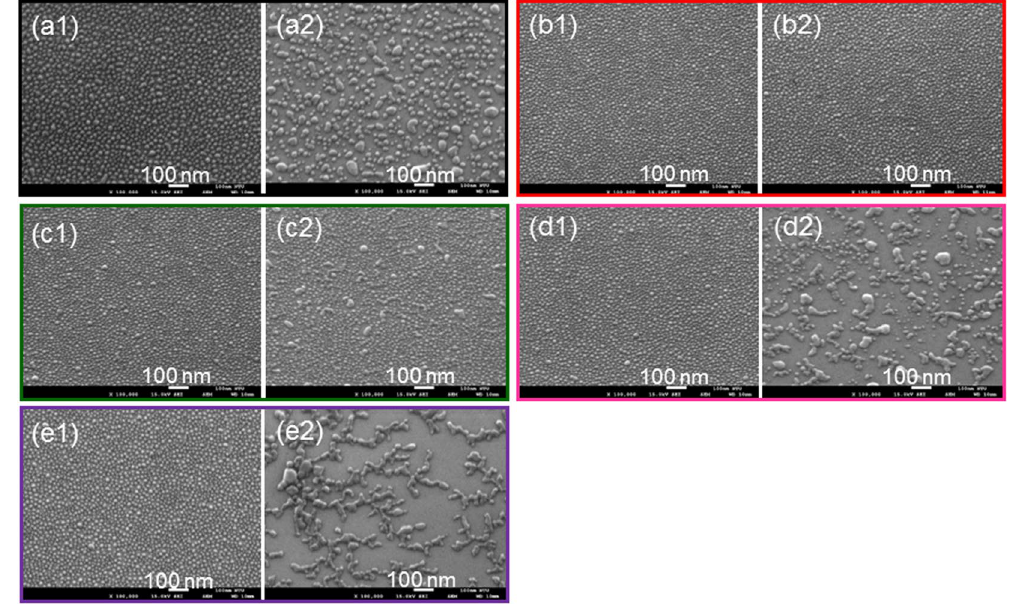
Figure 1. ( a1,a2 ) SEM images of fresh surface Ag NPs and the Ag NP structure 16 hours later under the indoor natural condition, respectively, on a GaN template. ( b1,b2 ) SEM images similar to parts ( a1,a2 ), respectively, when the sample is illuminated by a red LED at 650 nm in wavelength. ( c1 , c2 ) SEM images similar to parts ( a1,a2 ), respectively, when the sample is illuminated by a green LED at 520 nm in wavelength. ( d1,d2) [( e1,e2 )] SEM images similar to parts ( b1,b2 ), respectively, when the sample is illuminated by an UV LED at 395 (367) nm in